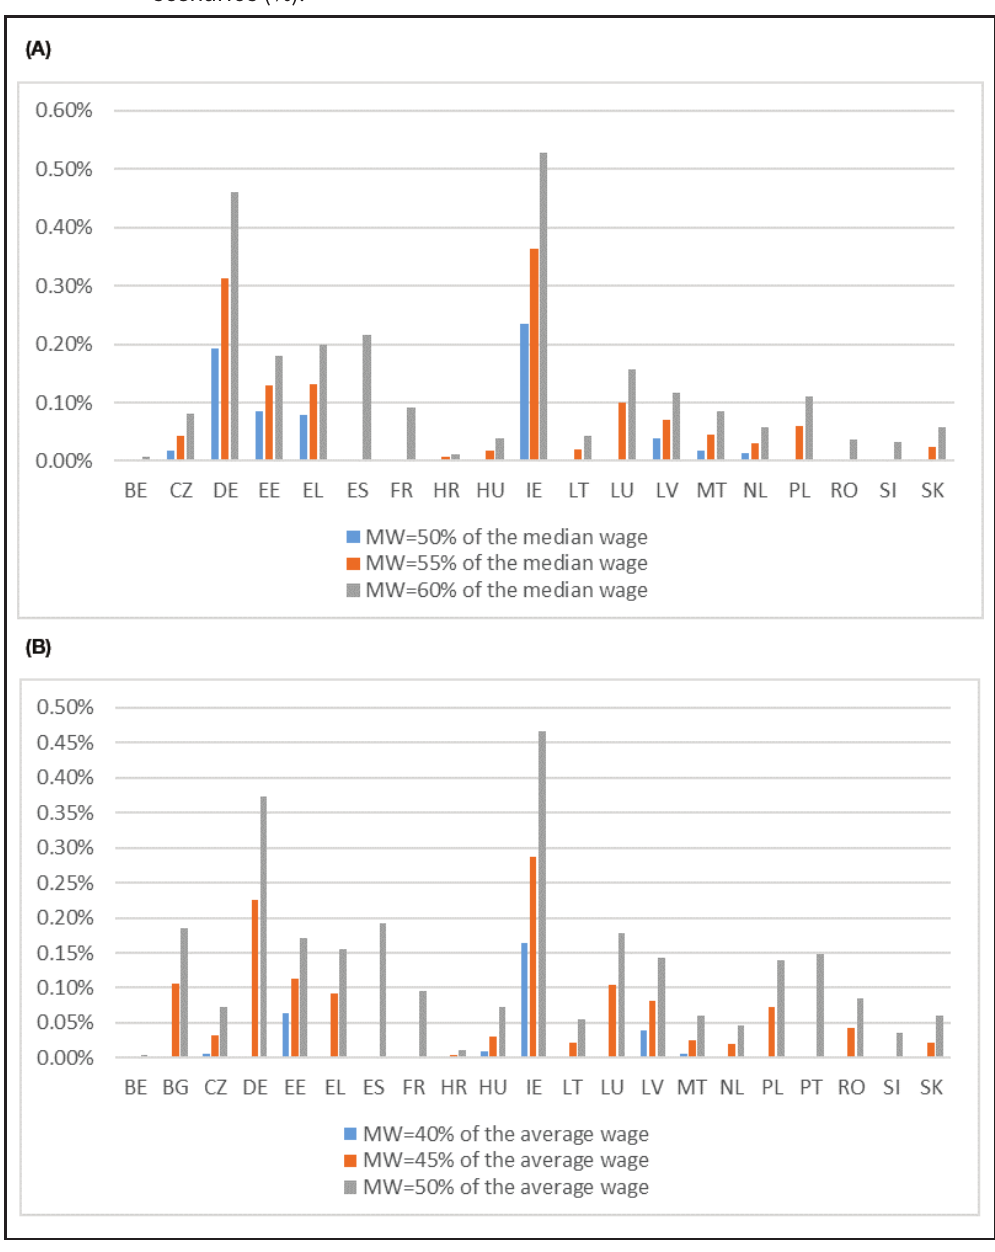
Figure A12 Estimation of possible positive labor supply effects in simulated HMW scenarios